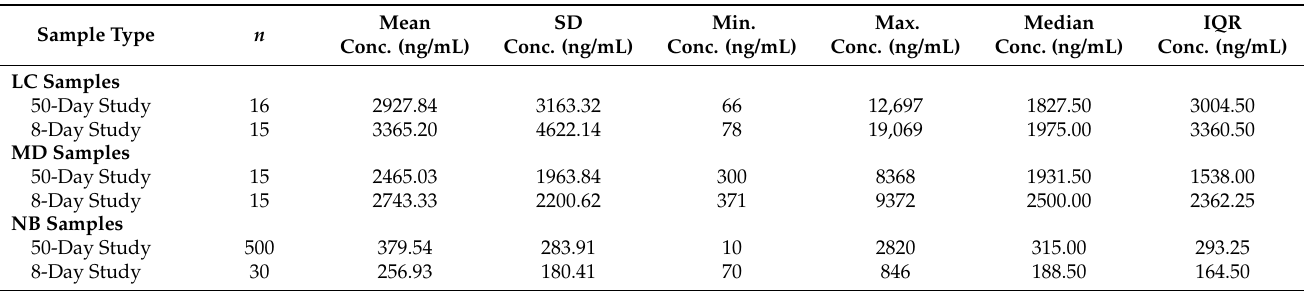
Table 2. Baseline CK-MM concentration (Conc.) for LC, MD, and NB